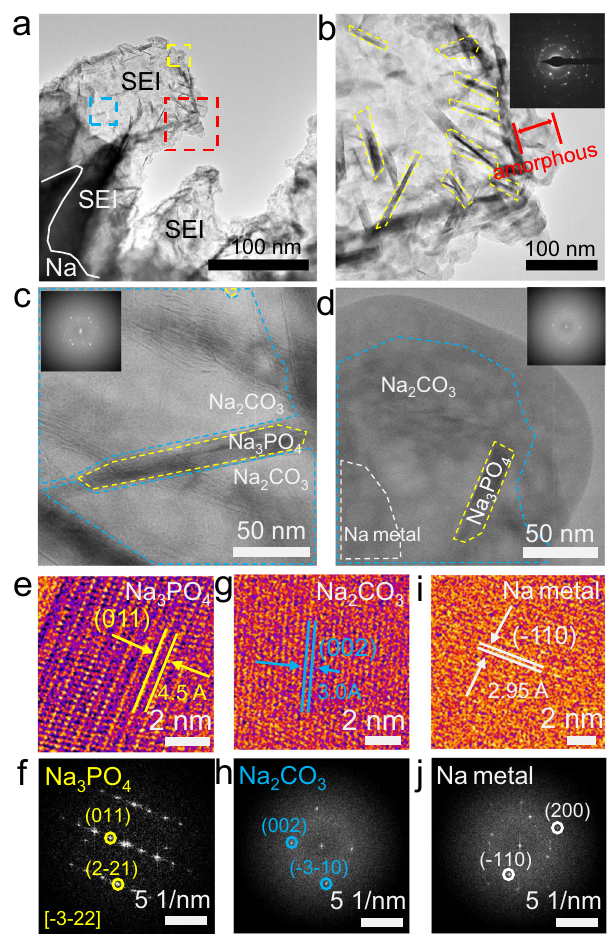
Fig. 2 Microstructure of the Na dendrites and SEI formed in FEC-free EC: DMC-based electrolyte after the 10th cycle. a Low-magni fi cation cryo- TEM of the thick SEI on Na metal. b Magni fi ed view of the regions in a outlined in red, c blue, and d yellow. The inserted FFTs in c , d show polycrystalline patterns containing Na 3 PO 4 and Na 2 CO 3 . e , f Representative HRTEMs and corresponding FFTs of Na 3 PO 4 , g , h Na 2 CO 3 , and i , j Na metal. (HRTEMs were obtained with an electron dosage of ~120 e Å − 2